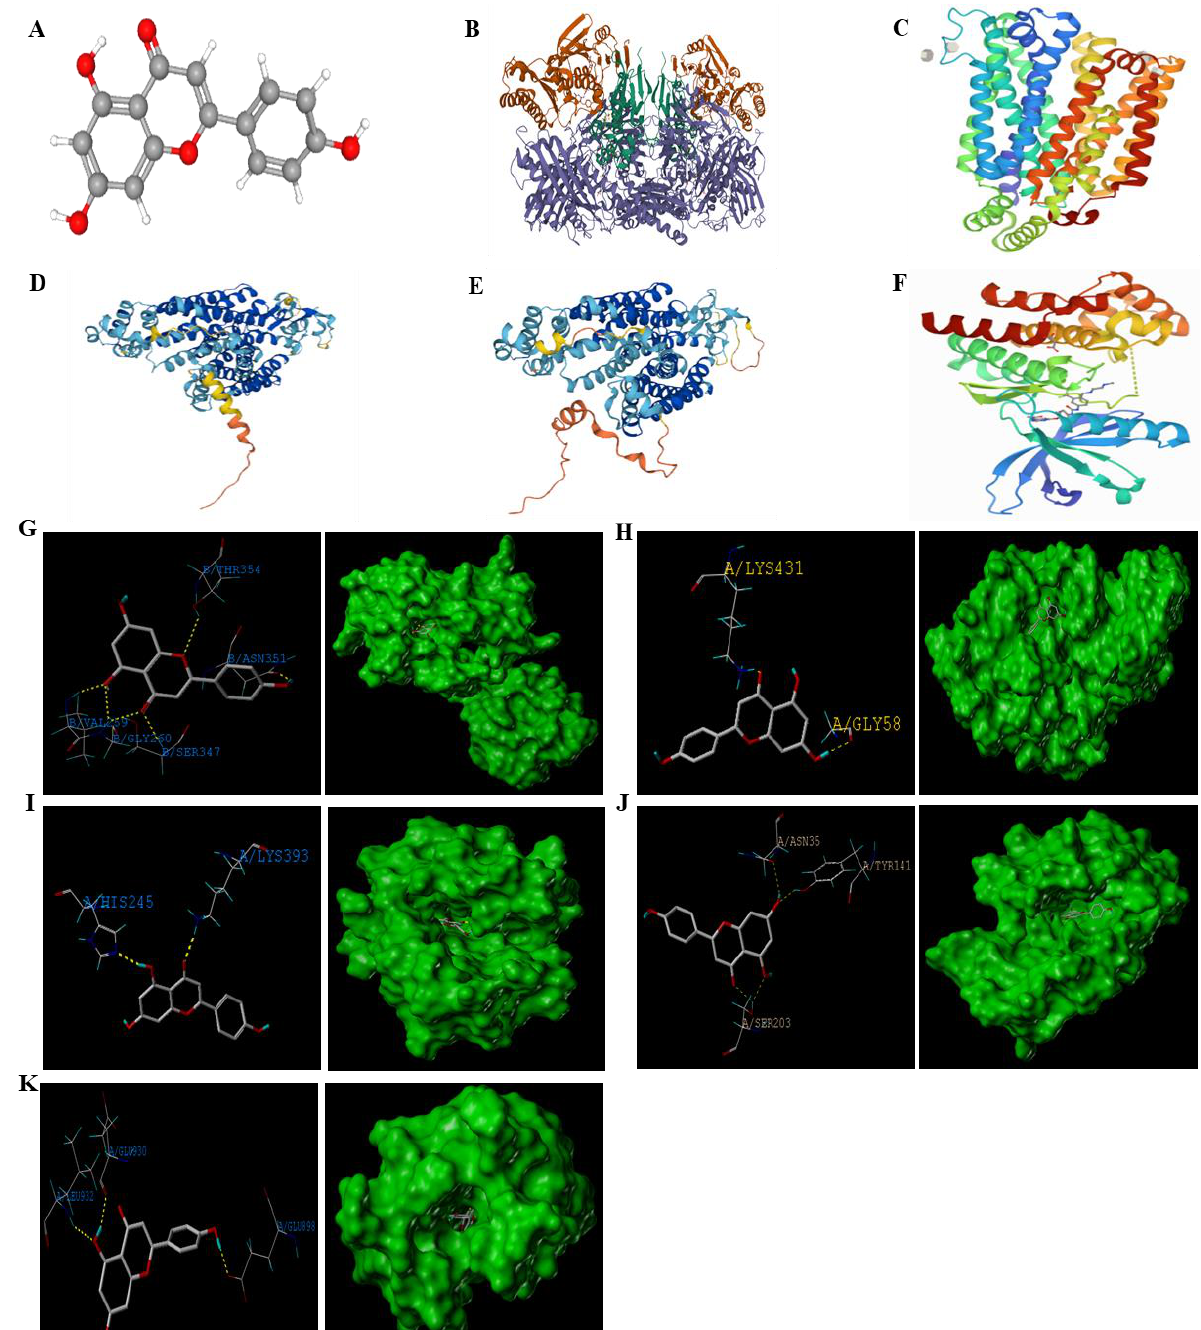
Figure 6. Interactions between apigenin with UA transporters and JAK2 protein by molecular docking. The 3D structure diagram of apigenin molecule ( A ). Crystal structure of XOD (PDB code, 1FIQ), GLUT9 (PDB code, 4GBY), URAT1 (PDB code, AF-Q96S37-F1), OAT1 (PDB code, AF-Q4U2R8-F1), and JAK2 (PDB code, 3UGC) proteins ( B – F ). Molecular docking diagram of apigenin with UA transporters and JAK2 proteins ( G – K ) .